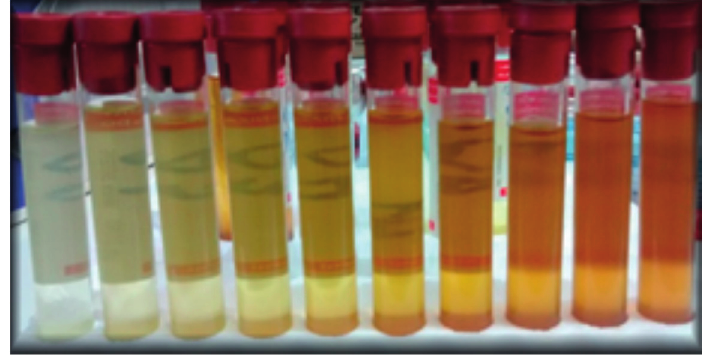
Figure 6. Changes in coloration of oil samples collected after each heating and cooling